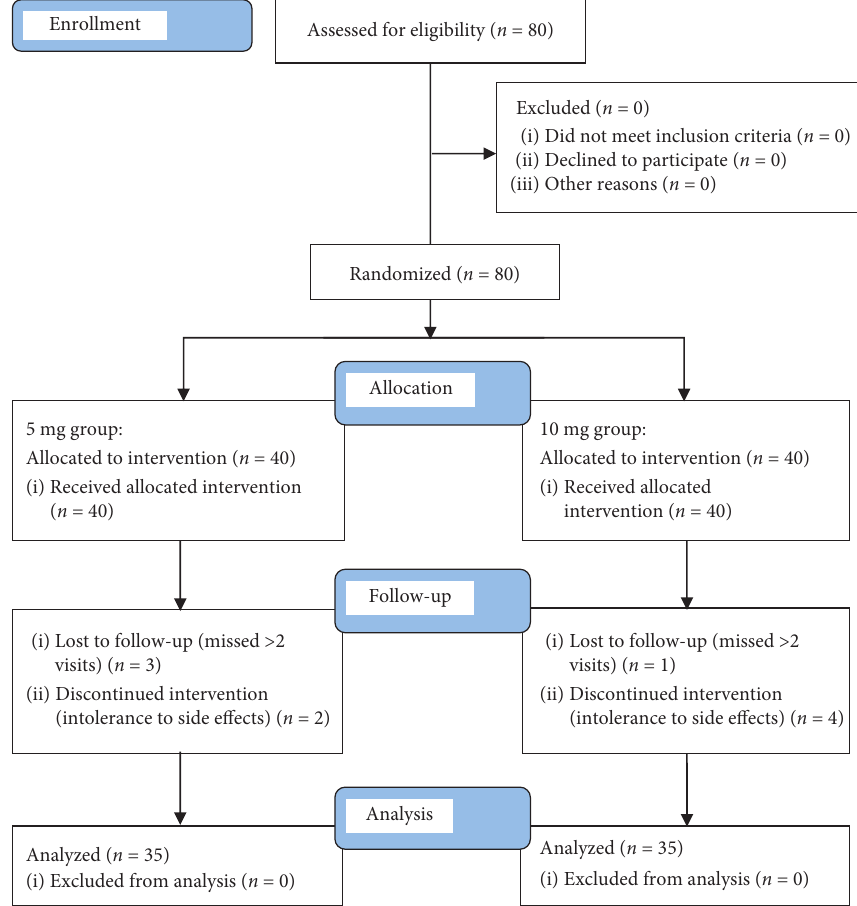
Figure 1: CONSORT flow diagram of patient